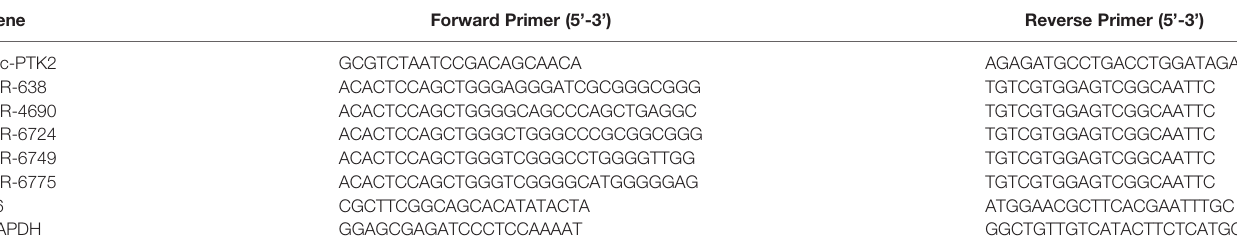
TABLE 1 | Primers.